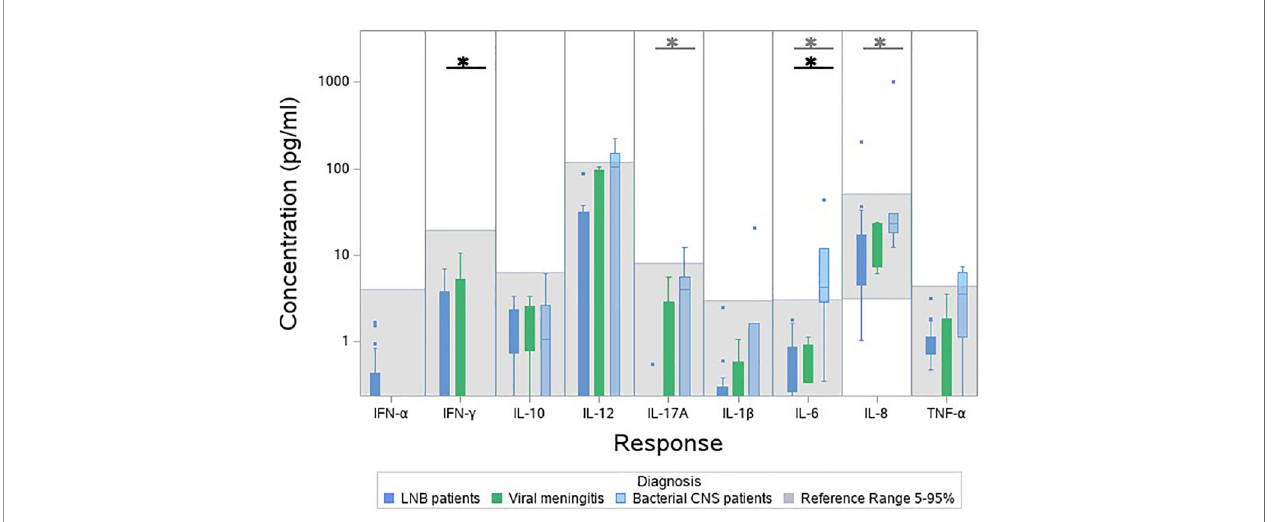
FIGURE 4 | Cytokine concentration in unstimulated blood samples from patients with other bacterial CNS infections (light blue), viral CNS infections (green), patients with LNB (dark blue) and references (grey). Bacterial CNS-infections was compared with LNB (grey stars) and bacterial CNS-infections was compared with references (black stars). * p <